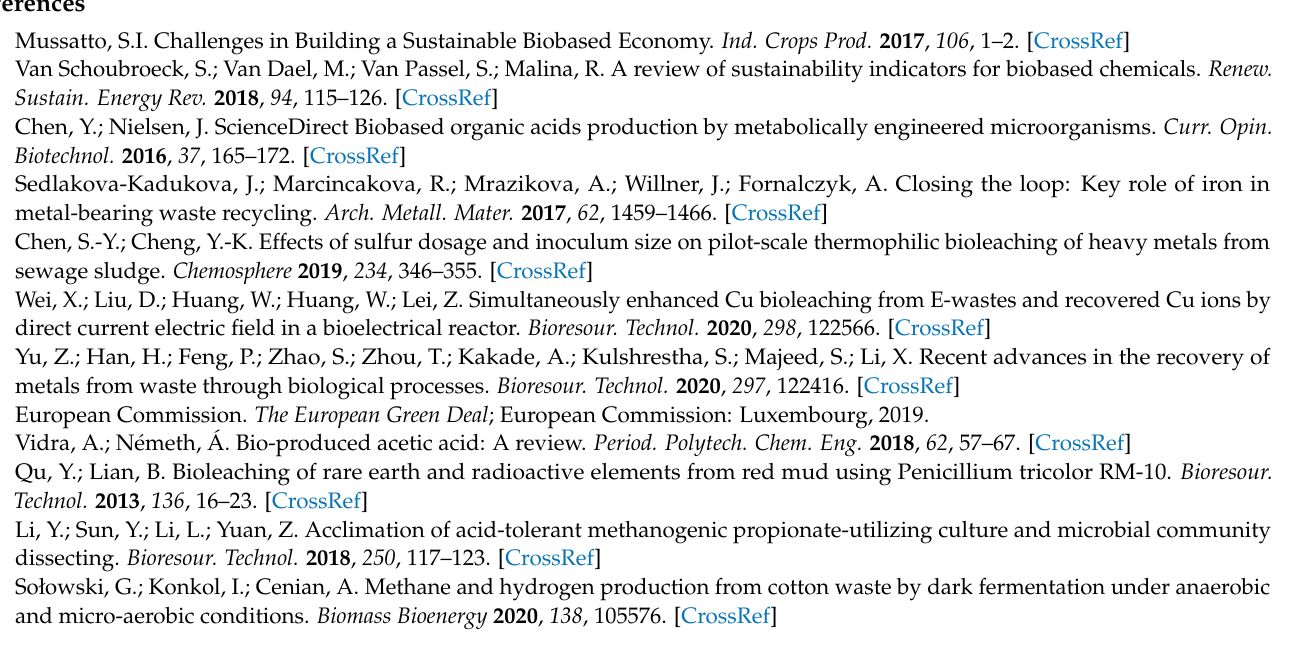
Table S1: Bioleaching by organic acid producers; Table S2: Bioleaching by inorganic acid